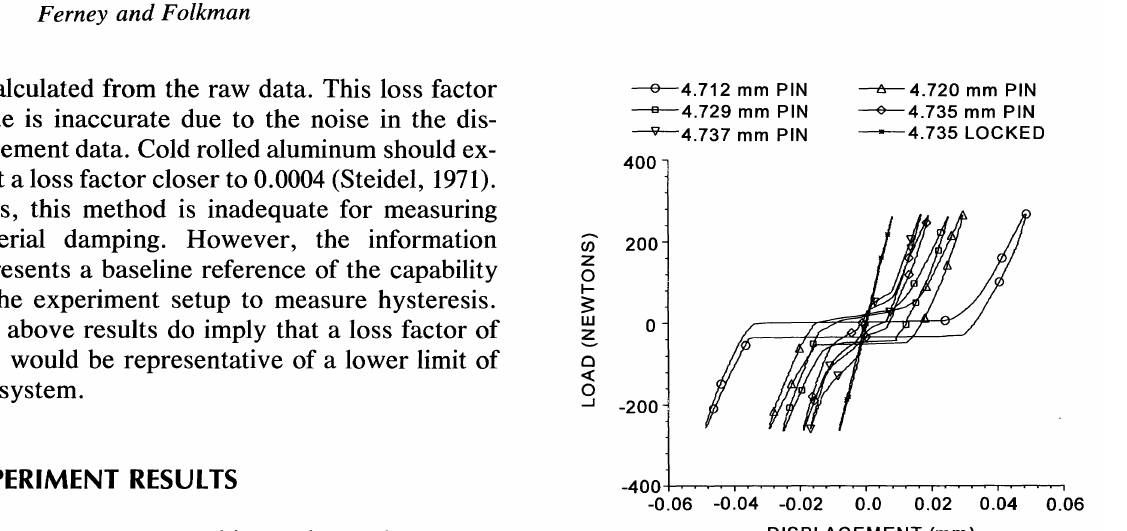
FIGURE 4 Plot of hysteresis tests for pins ranging from 4.534 to 4.712 mm diameter.